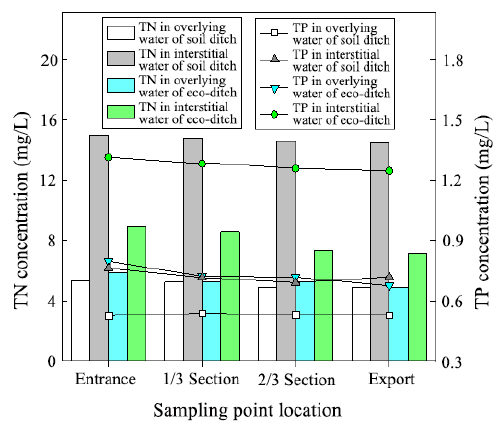
Figure 7. Changes of TN and TP concentrations along the way in the eco-ditch and the soil ditch. Table 2. Effect of sampling locations on water quality parameters of interstitial water and overlying water of the two ditches.